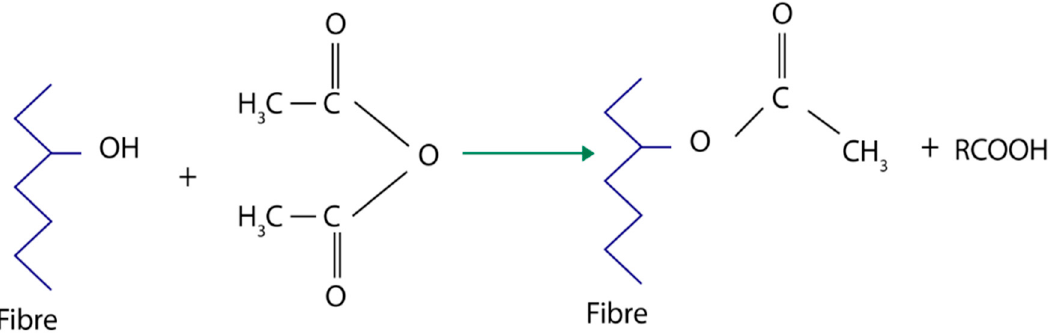
Figure 9. Reaction process of acetic anhydride with cellulosic fiber.